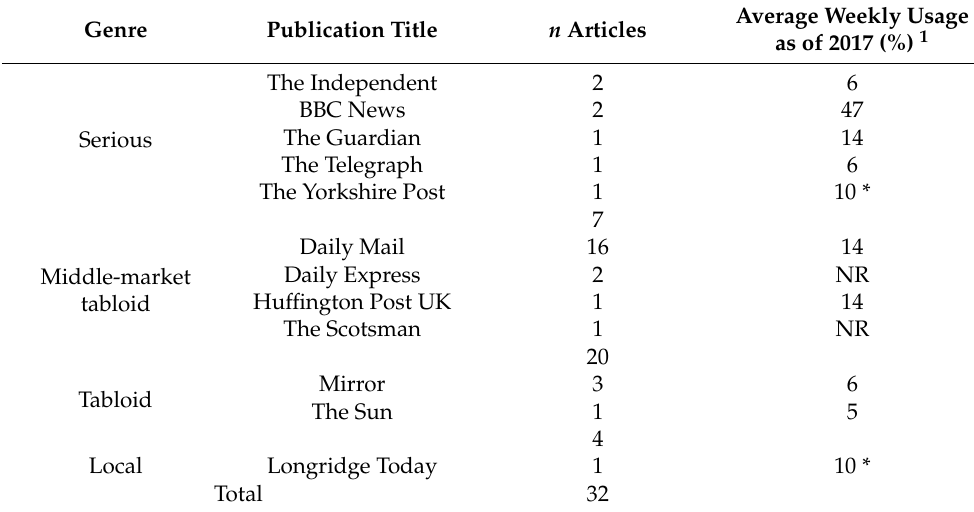
Table 2. Articles ( n = 32) by newspaper genre and publication title.